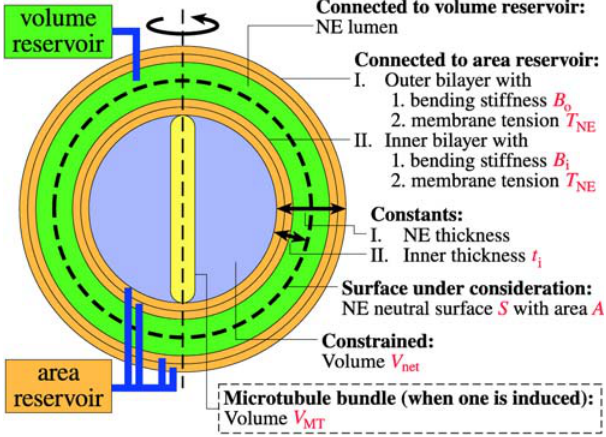
Figure 2. Minimal model describing the mechanics governing the geometries of interphase fission yeast nuclei and abnormal nuclei in which a n-MTB is induced.